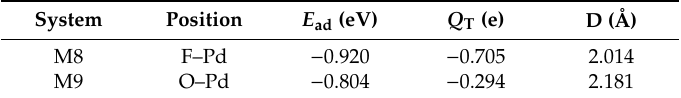
Figure 8. Adsorption structures of SO 2 F 2 on Pd 3 ‐graphene surface (distance in Å). Table 4. Structural parameters of SO 2 F 2 adsorption systems on Pd 3 ‐graphene surface. Position represents the approaching way, for instance, F–Pd means the SO 2 F 2 molecule approaches the Pd